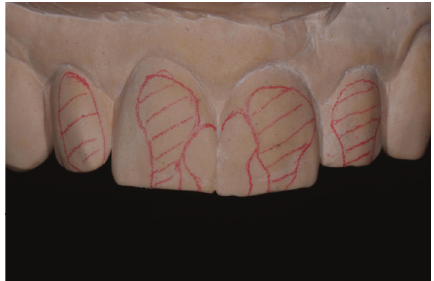
Figure 5: Minimal tooth preparation areas marked on the preoperative cast.